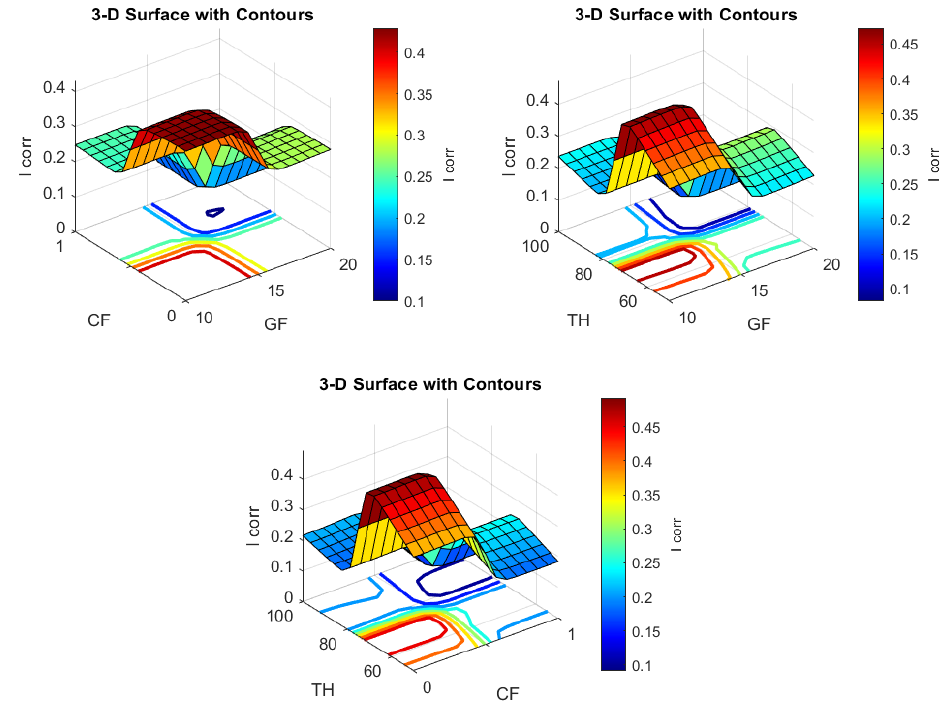
Figure 5. The 3D spatial shape that relates to the input controlling parameters.